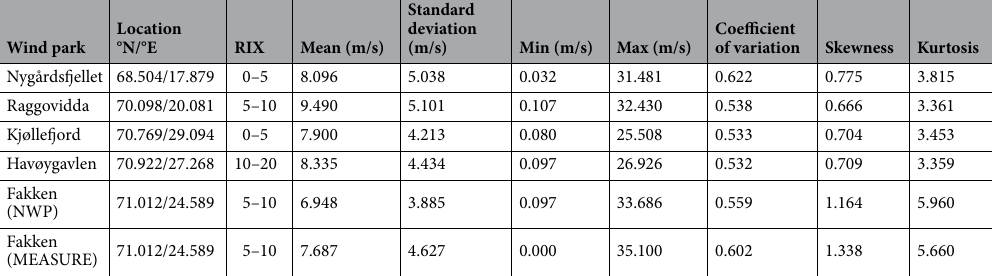
Table 1. The location of wind parks and statistics of their wind